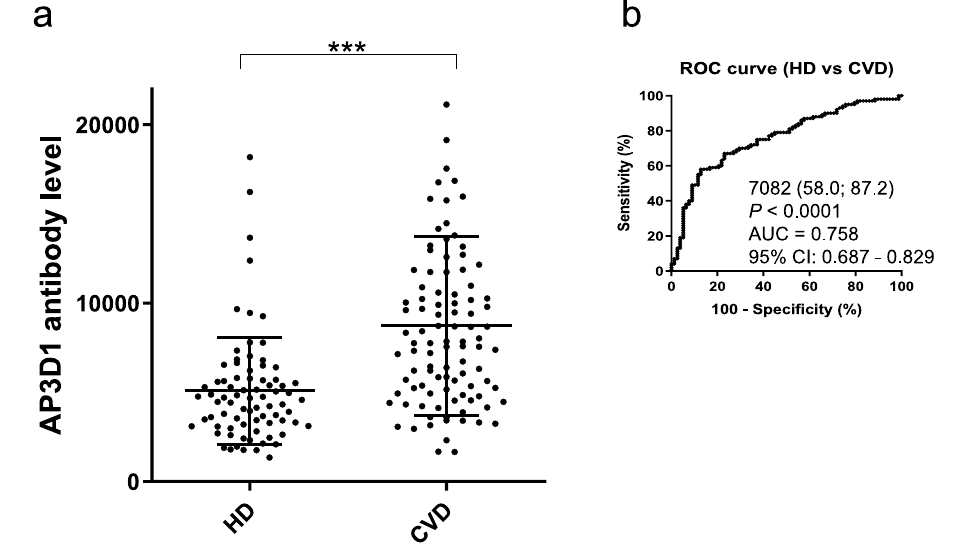
Figure 3. Comparing the serum AP3D1-Ab levels between HDs and cardiovascular disease (CVD) patients. This figure shows the s-AP3D1-Ab levels in HDs and CVD patients examined using AlphaLISA ( a ). The bars represent the average and average ± SD. P -values were calculated using the Mann–Whitney U test. *** P < 0.001. The data are summarized in Table 3. ROC curves to assess the ability of s-AP3D1-Abs to predict CVD are shown ( b ). The numbers in the figures are the same as those shown in Fig. 1. The results of the power calculation were shown in Supplementary Table S3.